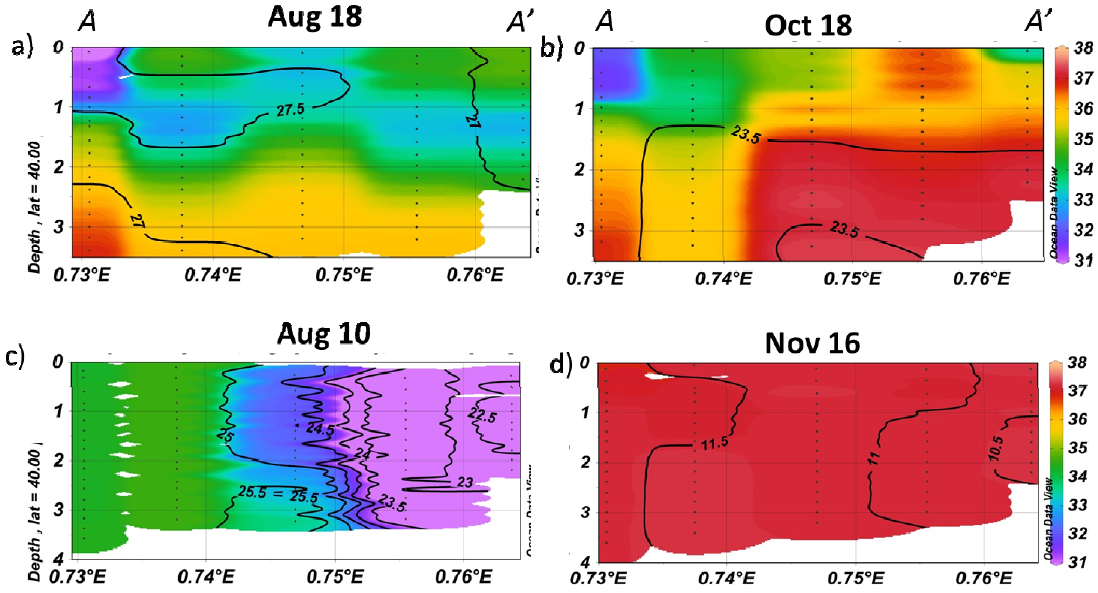
Figure 10. Vertical transect of ( a ) stratification summer situation, ( b ) stratification autumn situation, ( c ) situation during episode E1, ( d ) situation during episode E4. The color bar shows salinity values; black lines show temperature values.